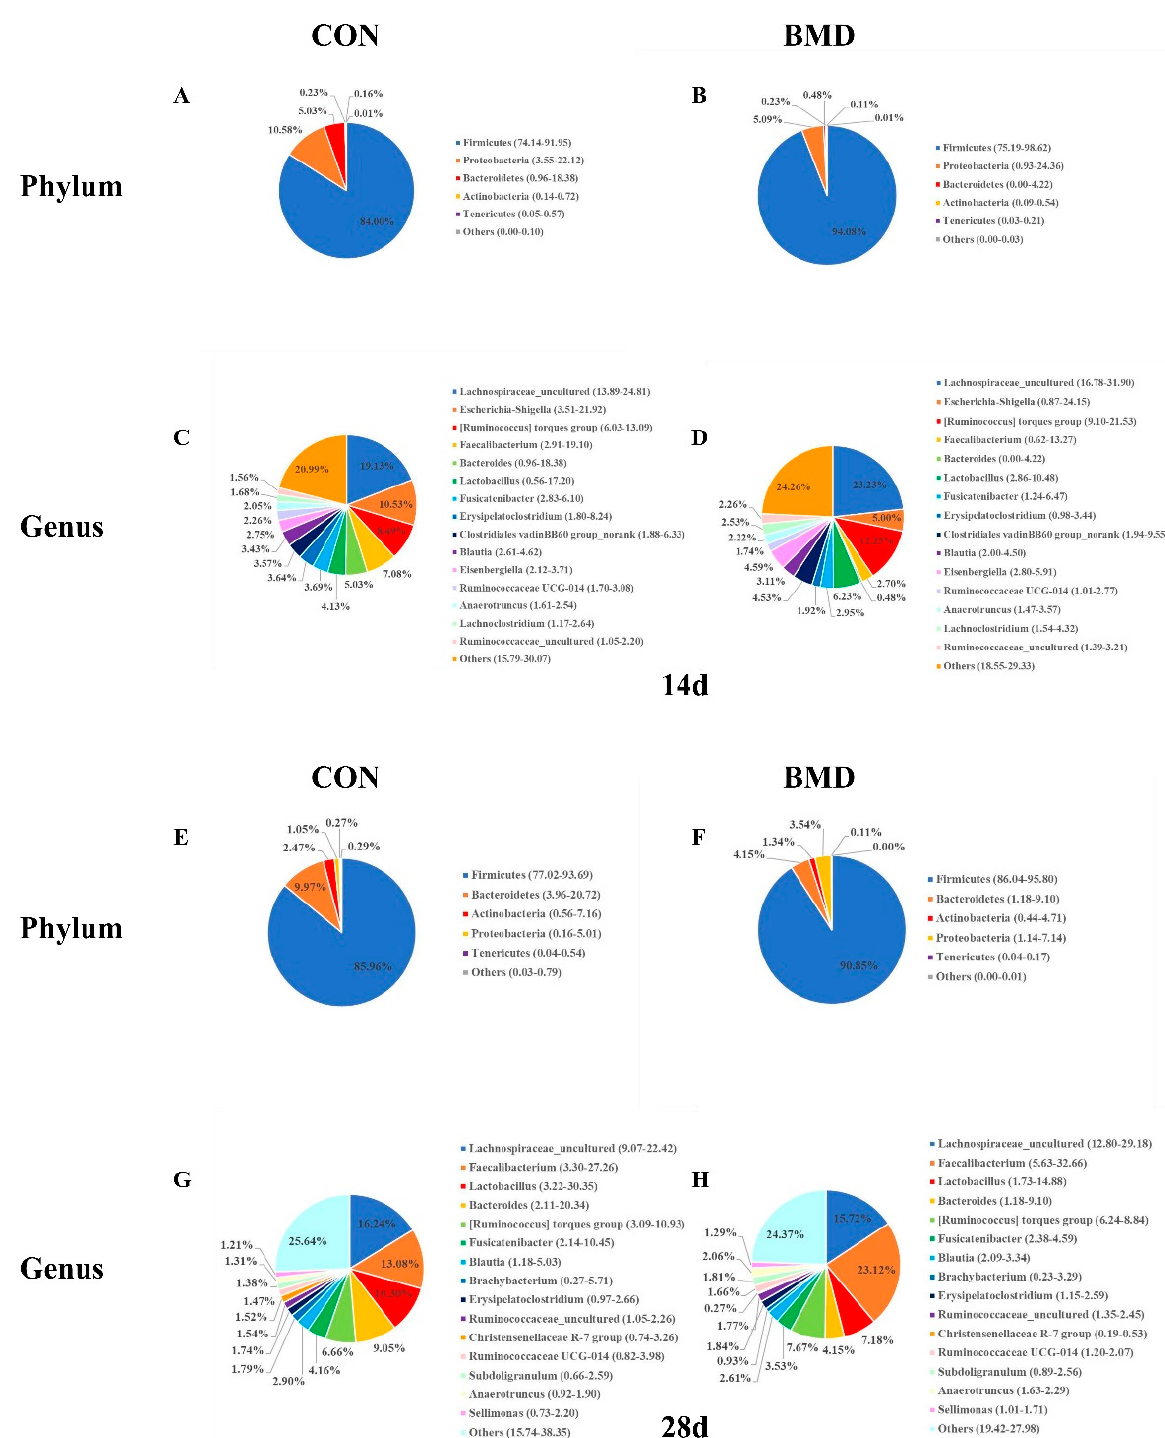
Figure 4. The bacterial community composition in the caecum of Day 14 ( A – D ) and 28 ( E – H ) chickens. Newly hatched chicks were fed an unmedicated basal diet for 28 days before the luminal content was collected. The composition of the bacterial community under the intervention of antibiotics was determined based on the phylum and genus levels. Only the top 5 (phyla) and top 15 (genera) are